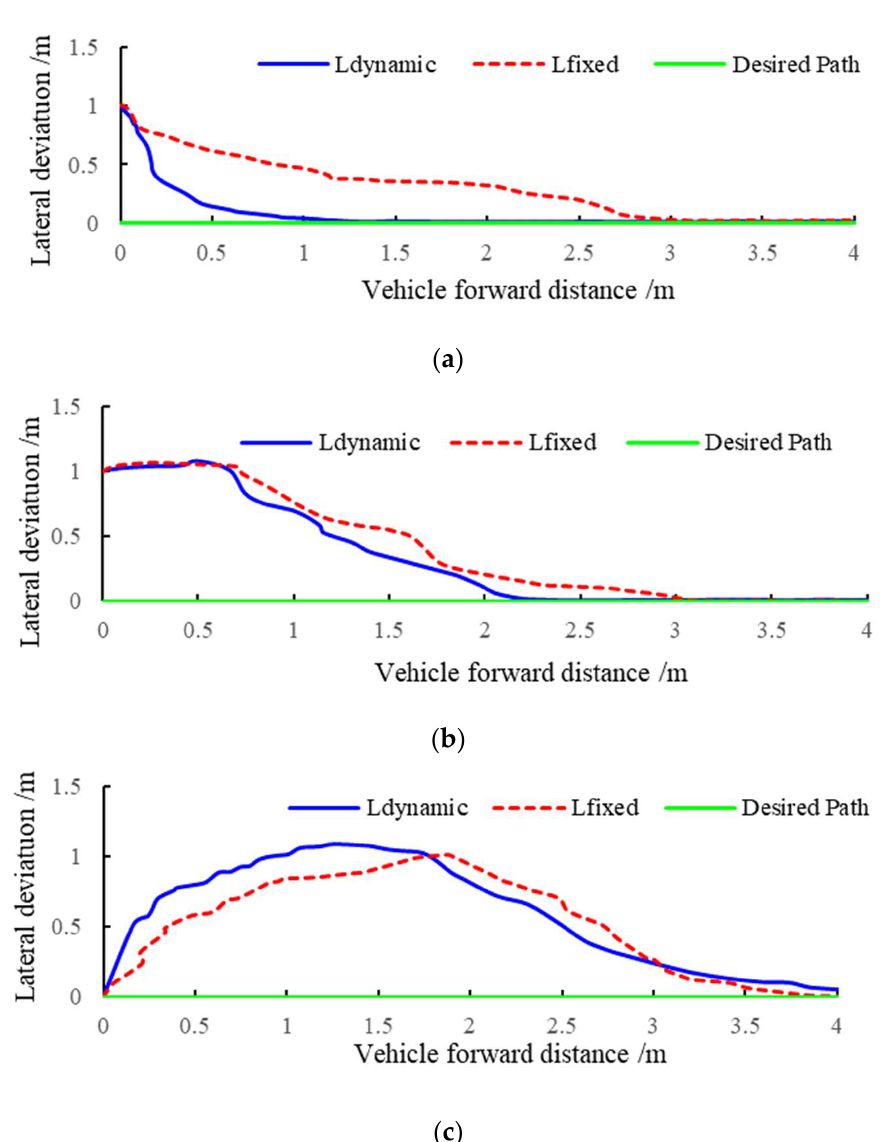
Figure 9. Locally enlarged trajectories of Figure 8. ( a ) Locally enlarged trajectories of Figure 8a; ( b ) locally enlarged trajectories of Figure 8b; ( c ) locally enlarged trajectories of Figure 8c.